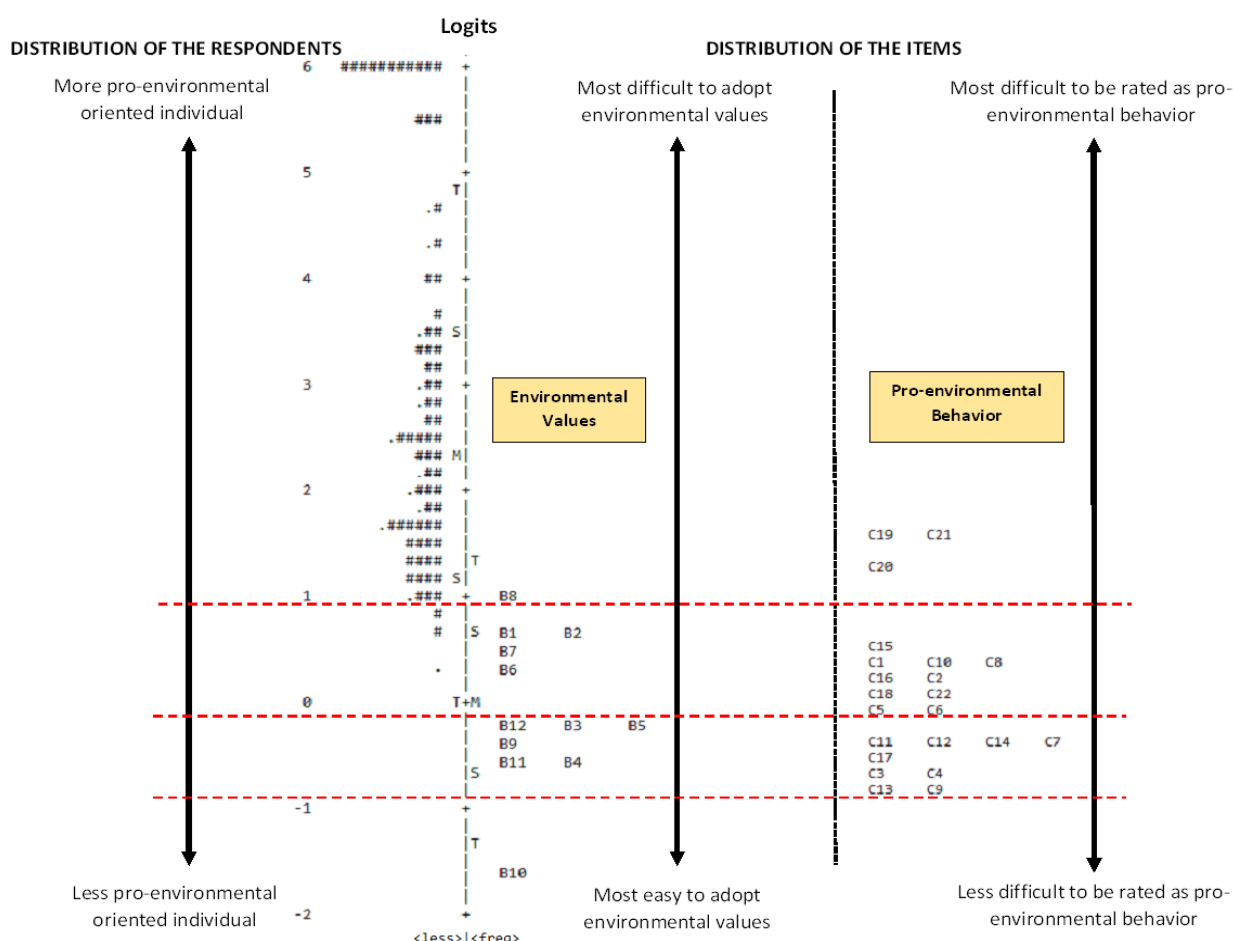
Figure 1. Item map for the constructs of environmental values and pro-environmental behavior for environmental conservation. Each ‘#’ represents two respondents and ‘.’ represents one respondent.